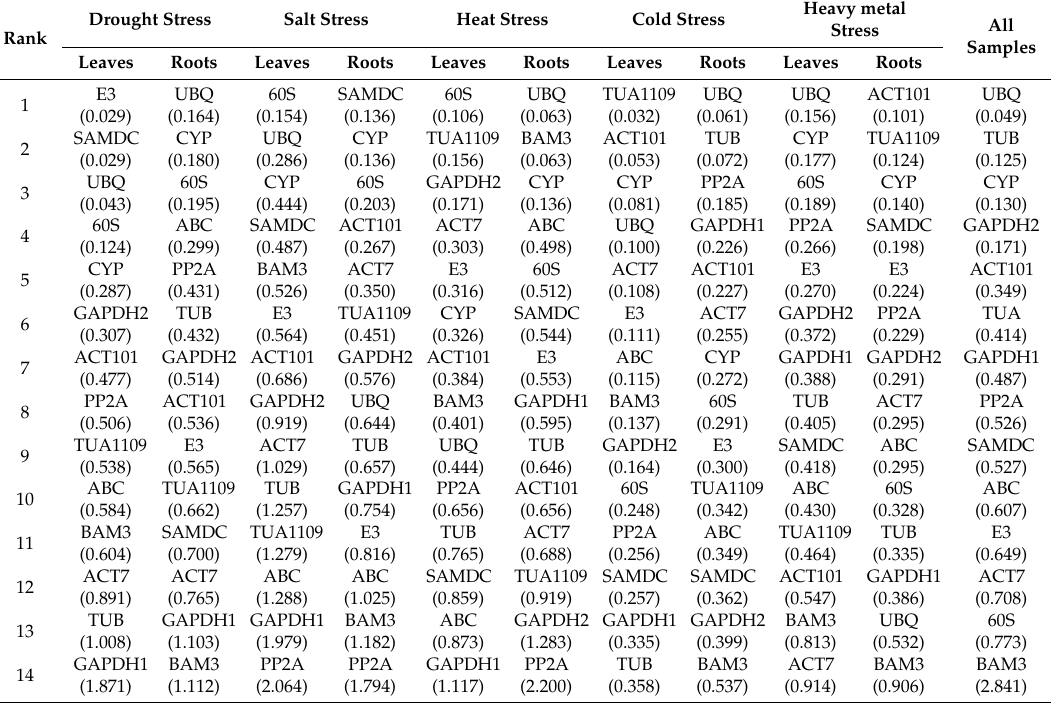
Table 2. Expression stability values for 14 white clover candidate reference genes calculated using NormFinder.